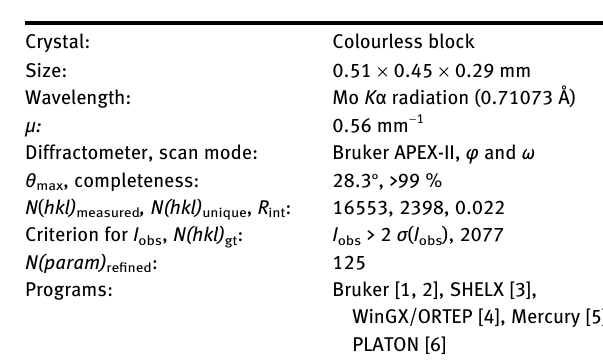
Table  : Data collection and handling.